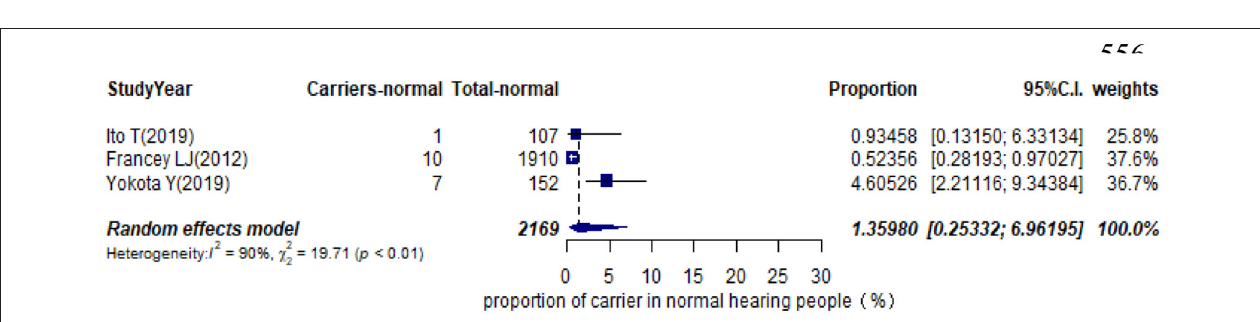
FIGURE 4 | Prevalence of carrier STRC mutation in non-GJB2 HI participants.